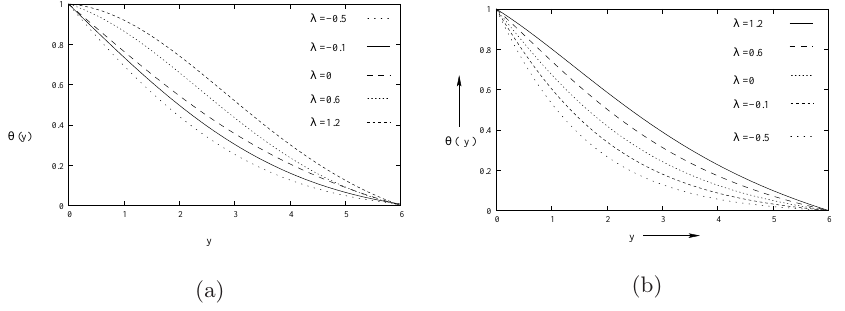
Figure 5. Variation of temperature with y for several values of λ when a) k 1 = 0 and Pr = 0 . 1 , b) k 1 = 0 . 5 and Pr = 0 . 1 .